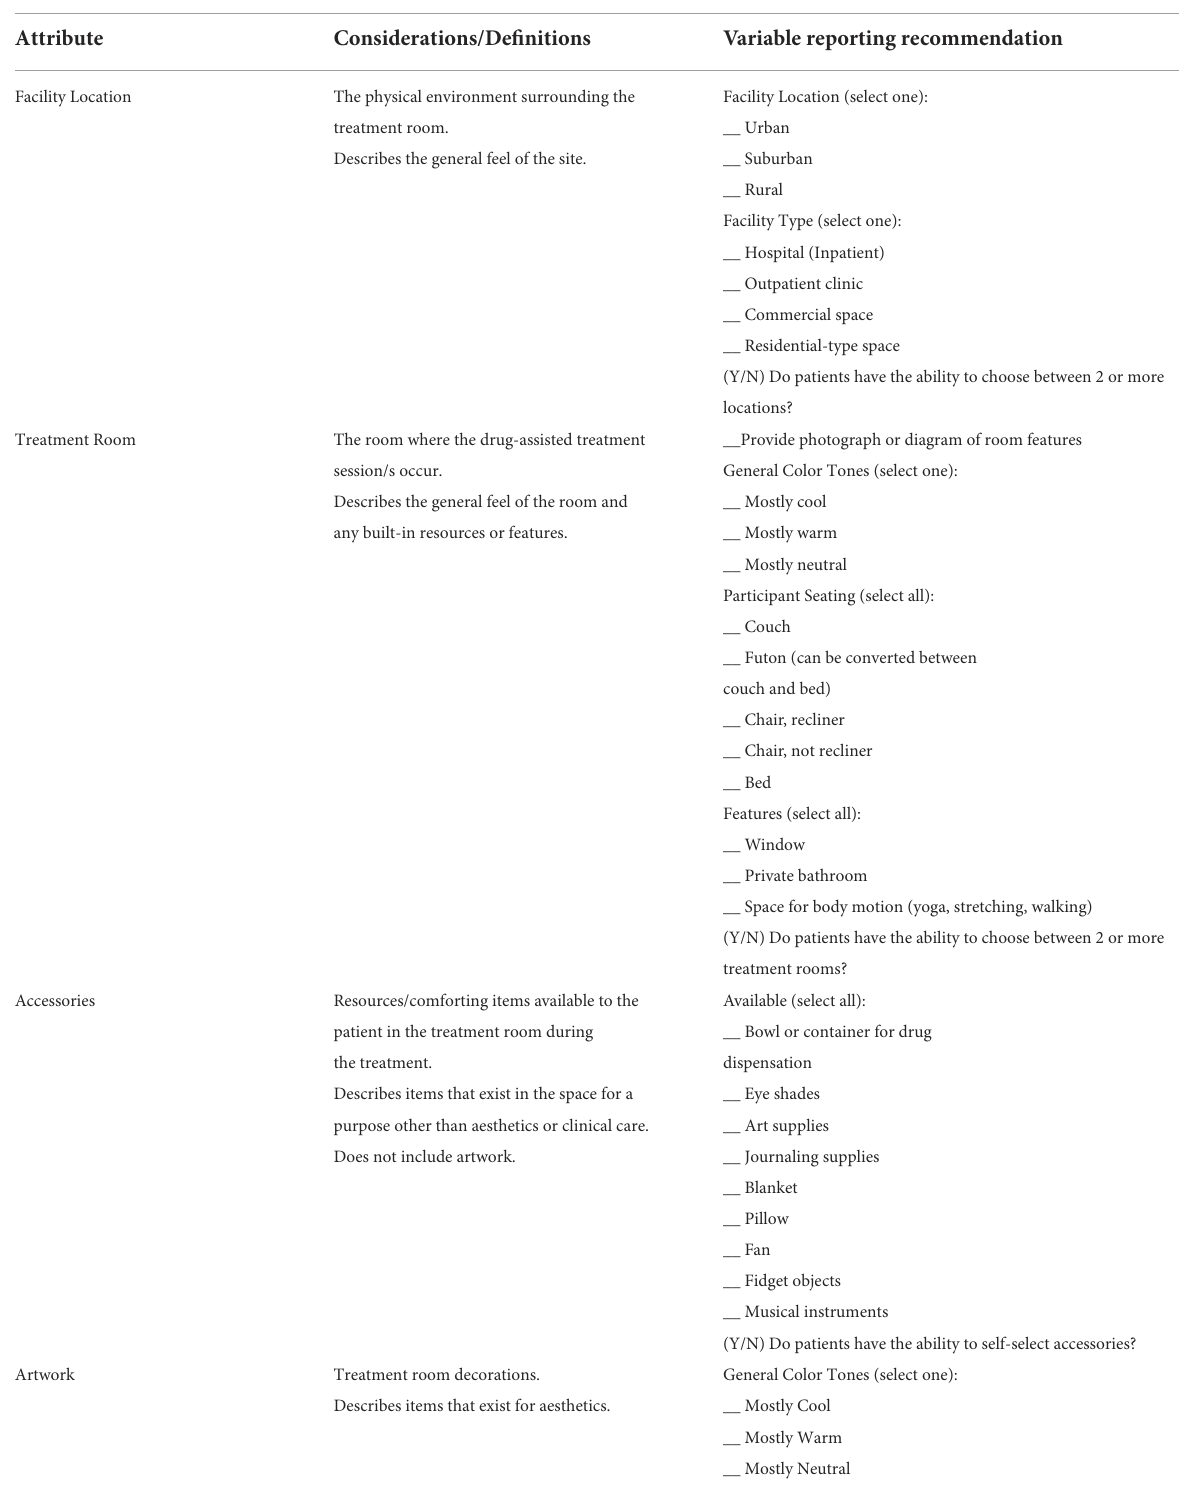
TABLE 1 Reporting recommendations for documenting physical and socio-cultural setting variables in psychedelic assisted therapy